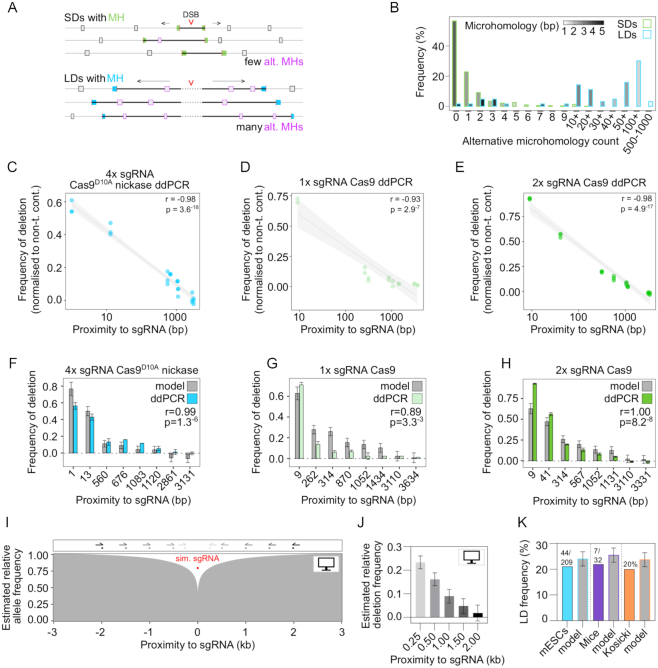
Larger deletion breakpoints do not occur at proximal microhomology sequences but are dependent on proximity to sgRNAs. (A) Schematic representation of LDs and SDs undergoing end-resection and bypassing alternative more proximal microhomologies during DNA repair. SD microhomologies are shown in green, LD microhomologies are shown in blue, and alternative microhomologies are indicated by pink boxes. The sequence included in the deletion is shown as a bold black line. (B) Quantification of alternative microhomologies that were found in the deleted sequences at Sites 7 and 9 SDs and across all LDs with microhomologies at their breakpoints. The colour gradient represents the mean microhomology score of all deletions within each bin. (C–E) Correlation between frequency of deletion determined by ddPCR and sgRNA proximity. Pearson correlation r and P values are indicated and a linear regression with 95% confidence interval is shown. (F–H) Deletion frequencies of real ddPCR data and model estimates with Pearson correlation r and P values indicated. (I) Model estimate of deletion frequency over a 6 kb window around a simulated sgRNA cut site with simulated PCR primers indicated as grey to black half arrows above the plot. (J) Relative predicted deletion frequencies at each of the simulated primer sites with 95% confidence intervals indicated. (K) Comparison between estimated and empirically determined deletion frequencies in two of our own independent data sets and one recent experiment reported in the literature (17).